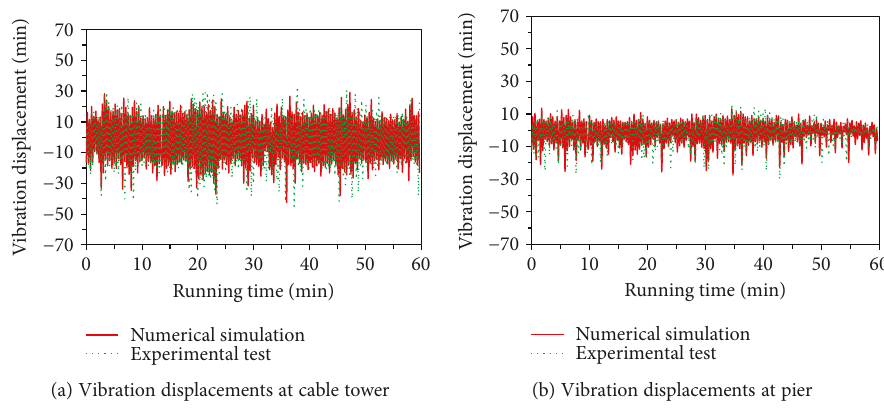
Figure 10: Comparison of bridge vibration responses between experiment and